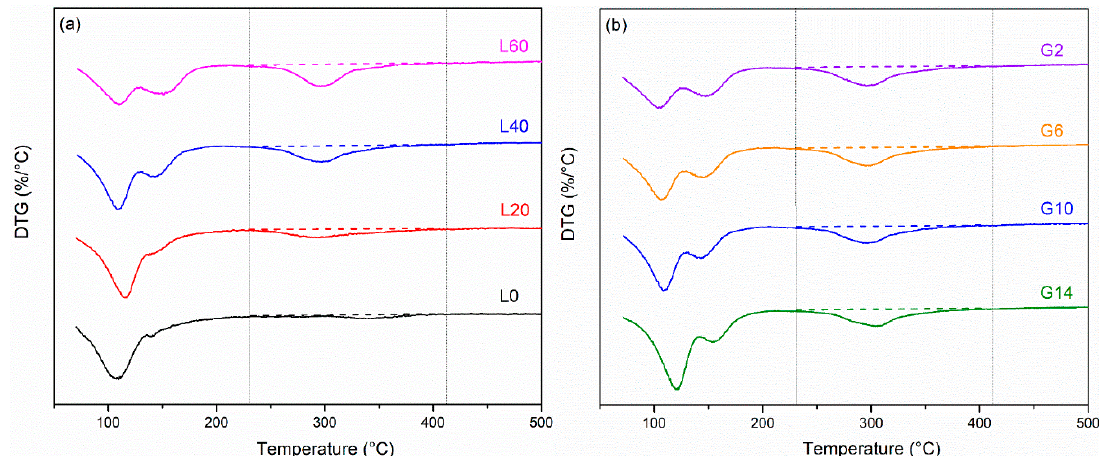
Figure 6. Differential thermogravimetry (DTG) showing Friedel’s salt peaks for ( a ) group L mixtures and ( b ) group G mixtures at 28 days.